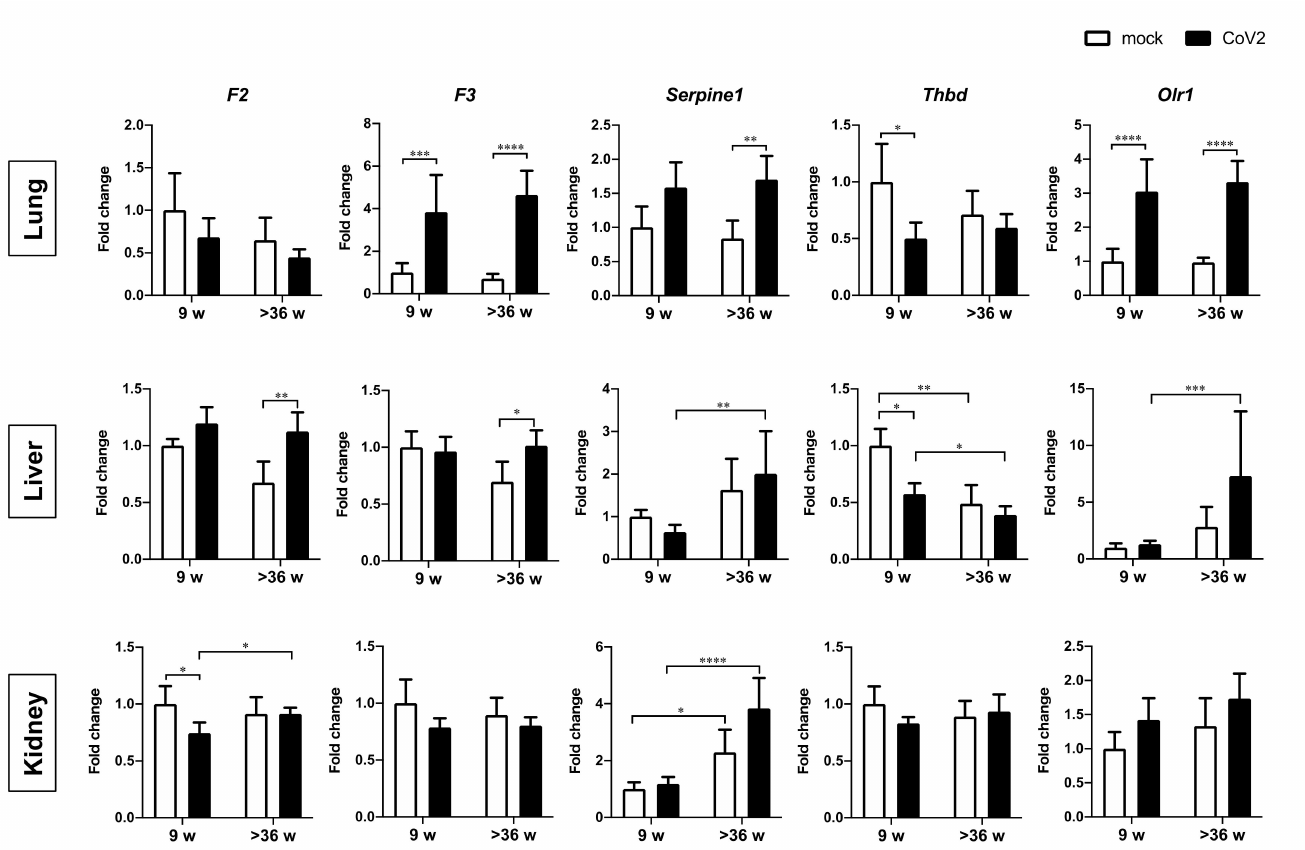
Figure 4. Gene expression of coagulation factors in the lungs, liver, and kidneys of young and aged hamsters infected with CoV2. Young (9 w) and aged (>36 w) hamsters were intranasally inoculated with PBS control (mock) or PBS containing SARS-CoV-2 virus (CoV2), and hamsters were euthanized at 6 dpi for the collection of lung, liver, and kidney samples for the measurement of coagulation-related factor gene expression. Gene expression levels of prothrombin-encoding F2 , tissue factor-encoding F3 , serine protease inhibitor, clade E, member 1 ( Serpine1 ), thrombomodulin-encoding Thbd , and oxidized low-density lipoprotein receptor 1 ( Olr1 ) are presented as the fold changes relative to those of young mock hamsters. Bars represent the mean ± SEM [mock (9 w), n = 6; CoV2 (9 w), n = 11; mock (>36 w), n = 6; CoV2 (>36 w), n = 14]. White and black bars indicate data from control and CoV2-infected hamsters, respectively. * p < 0.05, ** p < 0.01, *** p < 0.001, **** p < 0.0001, two-way ANOVA on dCt values with Sidak’s multiple comparison